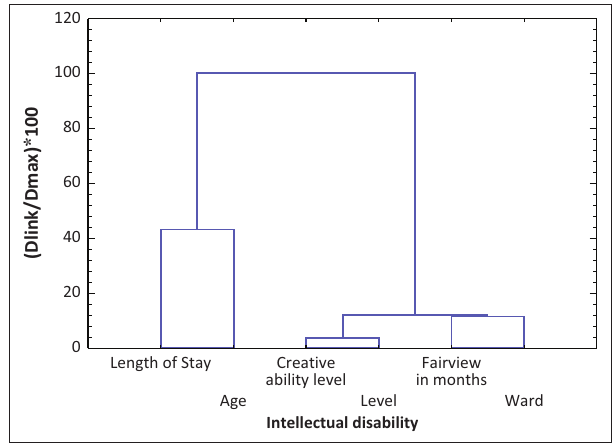
FIGURE 3: Cluster analyses Euclidean distances: Tree diagram for 6